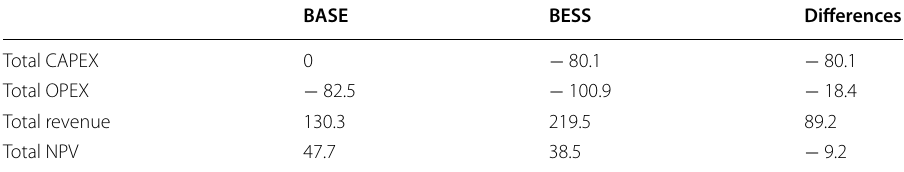
Table 3 Cost comparison between Base and BESS cases [mio DKK] BASE